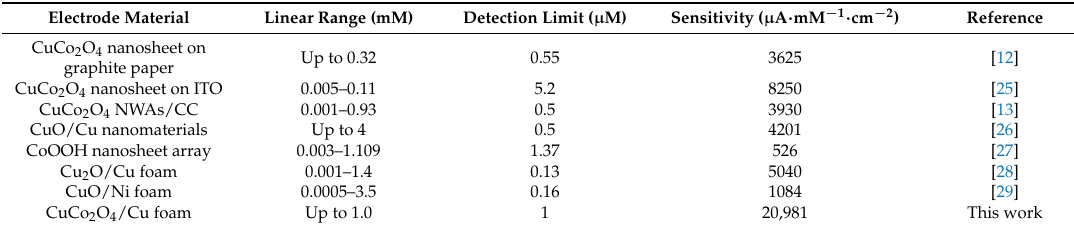
Figure 7. ( a ) Amperometric response of CuCo 2 O 4 /CF to the successive addition of the glucose solution with different concentrations in 0.1 M NaOH solution; ( b ) calibration curve for glucose oxidation on CuCo 2 O 4 /CF. Table 1. Performance comparison of CuCo 2 O 4 /CF with previous reports.